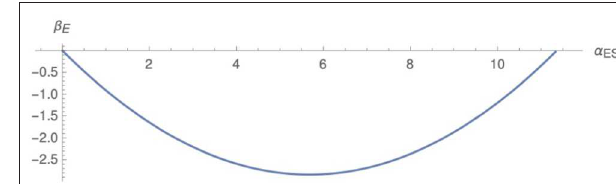
FIGURE 7 | β E as function of α ES